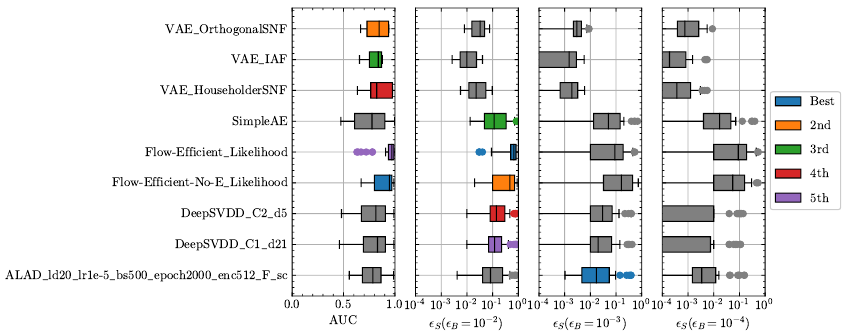
Figure 17: Box plots summarizing the anomaly detection techniques applied to all of the new physics signals. The colors denote the techniques that have the highest minimum scores for each of the figures of merit. No technique has ε = 10 − 4 and only one ALAD model has ε all physics signals for ε B = 10 − 3 physics signals at ε B